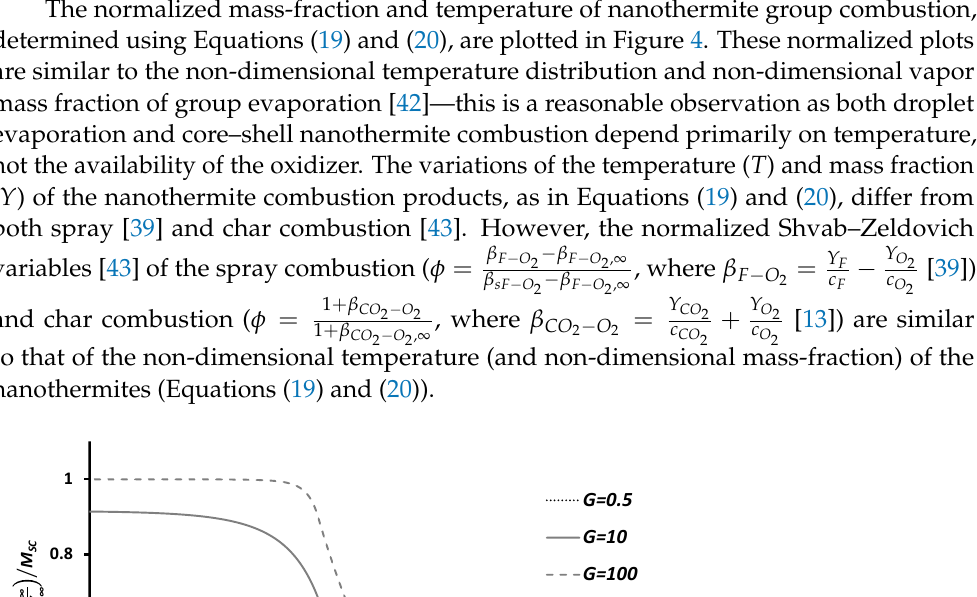
Figure 4. Variation of the quasi-steady non-dimensional temperature dimensional mass fraction ermite group. T s represents the temperature in proximity to isolated particle combustion as defined in Equation